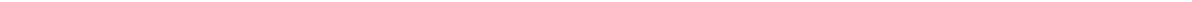
Fig. 7 Impairment of nucleo-cytoplasmatic FUS shuttling leads to DNA damage, neurodegeneration and aggregate formation. a Time course of nuclear FUS withdrawal after addition of PARP1 inhib. (top gallery) or etoposide (eto, bottom gallery) in WT FUS-GFP MNs at 21 DIV. b Distinct inhibitory kinetics of FUS-dependent DNA repair through etoposide and PARP1 inhib: recruitment-withdrawal of FUS-GFP to nuclear laser cuts as for Fig. 6a on WT FUS-GFP MNs after PARP1 inhibitor (top) or etoposide (bottom) addition at indicated time points, i.e. before and after loss of nuclear FUS (corresponding red boxes in a ), bars: 10 µ m (Supplementary Movie 12). c Quanti fi cation of b . d FUS-GFP recruited to Laser cut in MNs double-treated 24 h with compounds as indicated (Supplementary Movie 13). Note the inhibition of recruitment to the cut (boxed areas) in mutant FUS-GFP P525L cells (far left) through double treatment with DNA-PKi and PARP1i whereas DNA-PKi alone led to a rescue (Fig. 6c, Supplementary Movie 6), suggesting that PARP1 functions upstream of DNA-PK in DNA damage response. Furthermore, note that inhibiton of recruitment through etoposide or arsenite in WT FUS-GFP (Fig. 6c, Supplementary Movie 6) was reverted through double treatment with either DNA-PKi or AdOx, suggesting a potent counterbalancing of etoposide/ arsenite-driven displacement of FUS from the nucleus, thereby rescuing FUS recruitment to the cut (boxed areas). e Quanti fi cation of d . f Compounds impacted on nuclear FUS-GFP levels in MNs: double treatments Mut versus WT as for d . Note how DNA-PK inhib. or AdOx drove FUS-GFP back into the nucleus under conditions that normally lead to nuclear export of FUS (i.e. PARP1, etoposide or arsenite treatment, Fig. 6e). g Western blot (WB) analysis of markers for c-NHEJ DNA damage response (phospho and total DNA-PK, KU70 & KU80) and a-NHEJ (LIG1, PARP1 total and cleaved) on total lysates of MNs treated for 72 h as indicated. GFP, β -actin served as loading controls. h Densiometric quanti fi cation of g , WT (blue) versus FUS (red), mock only. Graphs show fold change over mean WT (mock baseline = 1) to reveal phenotypic differences of quasi untreated FUS over WT. i Densiometric quanti fi cation of g for all treatments. Graphs show fold change over respective cell line mock to reveal the compound response of each line (WT, blue, versus FUS, red) over its respective mock baseline ( = 1). Statistics ( h , i ): data are plotted as mean, error bars = STDEV, one-way ANOVA with post-hoc Bonferroni test (*, **, *** P values of 0.05, 0.01, and 0.001, respectively, N =